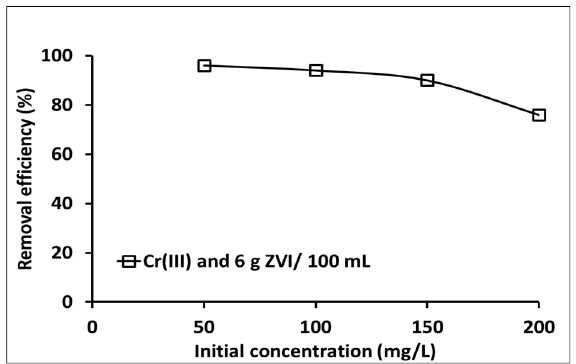
Fig. 4. Effect of initial concentration on the removal efficiency of chromium ions onto ZVI at pH 5.5, 50 mg/L initial contaminant concentration, and 250 min contact